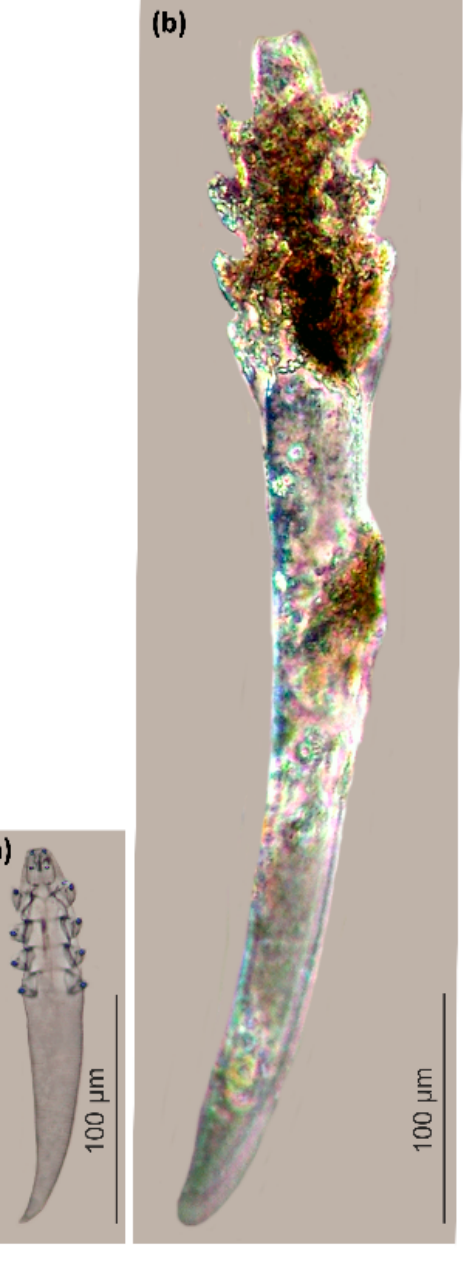
Figure 2. Demodex bialoviensis ( a ) and Demodex bisonianus ( b ), scaled.